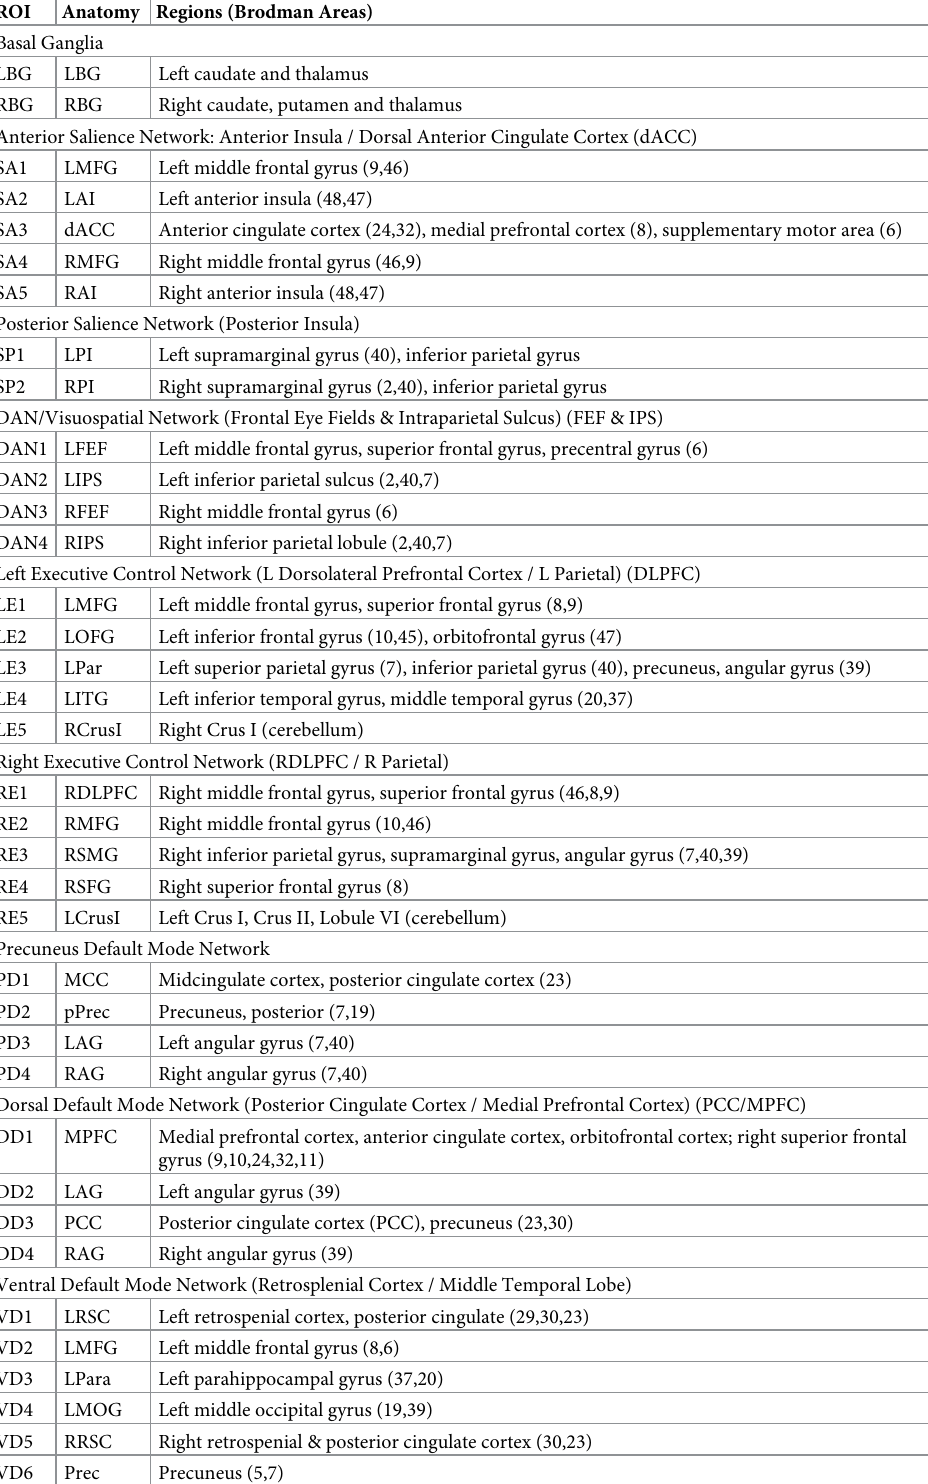
Table 1. Abbreviations for seed regions in each a priori network defined by Shirer et al. [31]. Additional informa- tion about each ROI is shown in Supplementary Materials S1 Table. ROI Anatomy Regions (Brodman